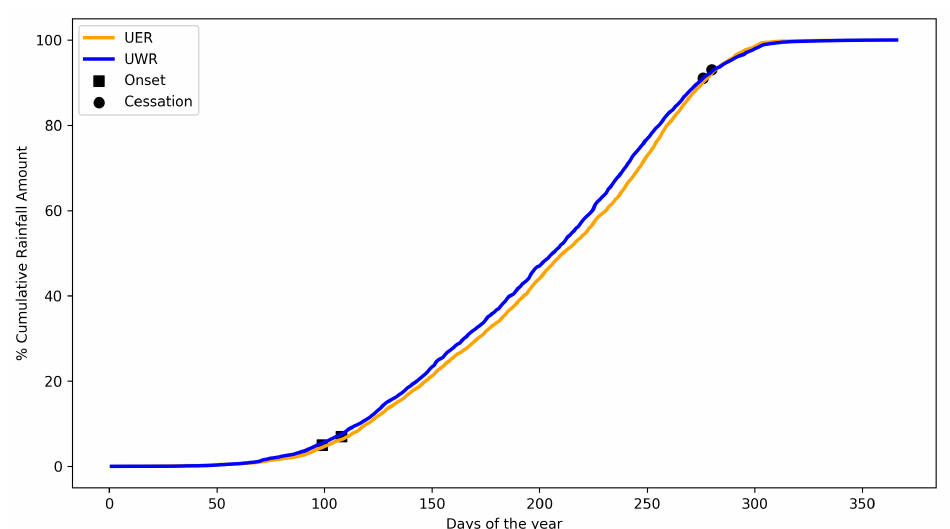
Figure A1. The percentage cumulative rainfall amount averaged over 1981–2019 in the Upper East (UER) and Upper West (UWR) regions.